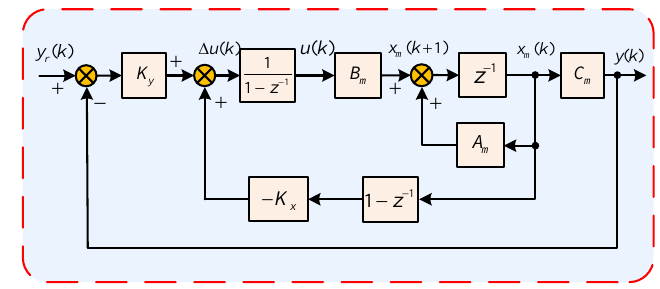
Figure 2. Block diagram of the discrete-time model predictive control system.